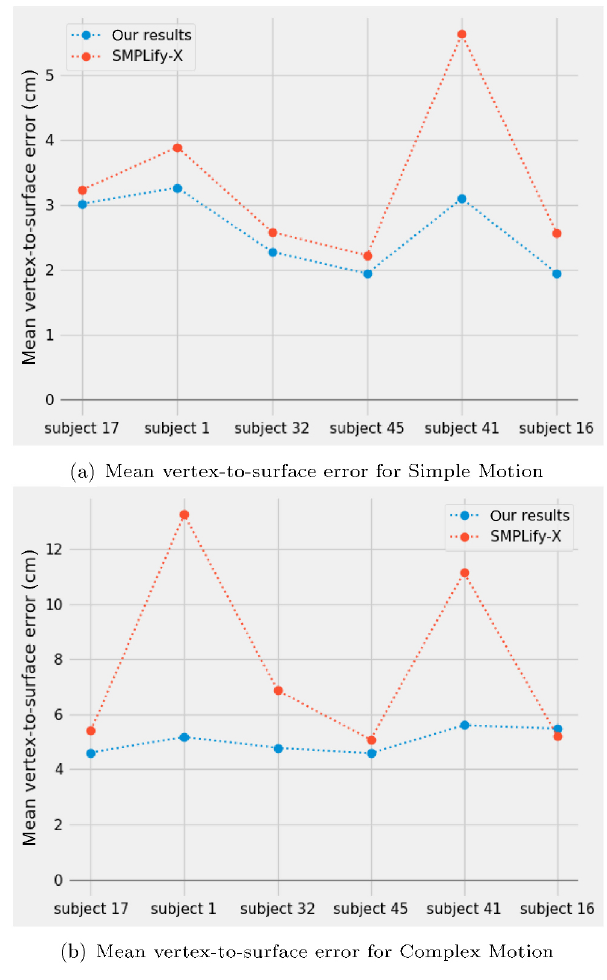
Fig. 12 Mean vertex-to-surface error for all six subjects and both analyzed motions. Overall, our method achieves a lower mean vertex- to-surface error than SMPLify-X. Table 4 Mean and standard deviation of vertex-to-surface error for both methods and